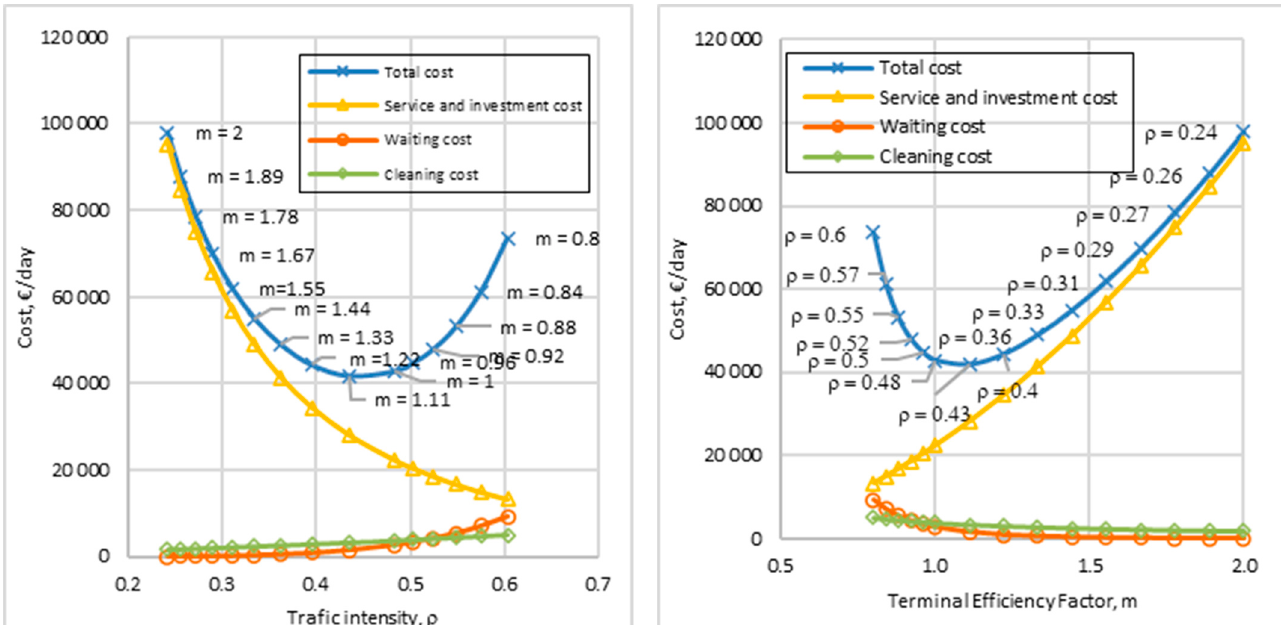
Figure 8. Total cost, cost of berth service, cost of air pollution cleaning, and cost of waiting as a function of traffic intensity ( left ) and terminal efficiency factor ( right ).